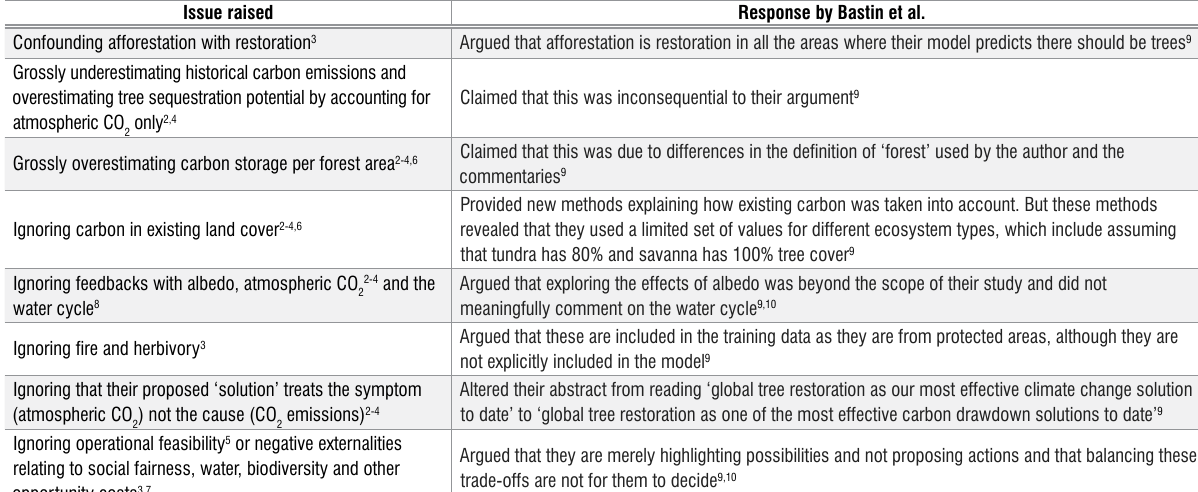
Table 1: Flaws, errors or omissions of Bastin et al.’s 1 analysis highlighted in technical comments and letters Issue raised Confounding afforestation with restoration